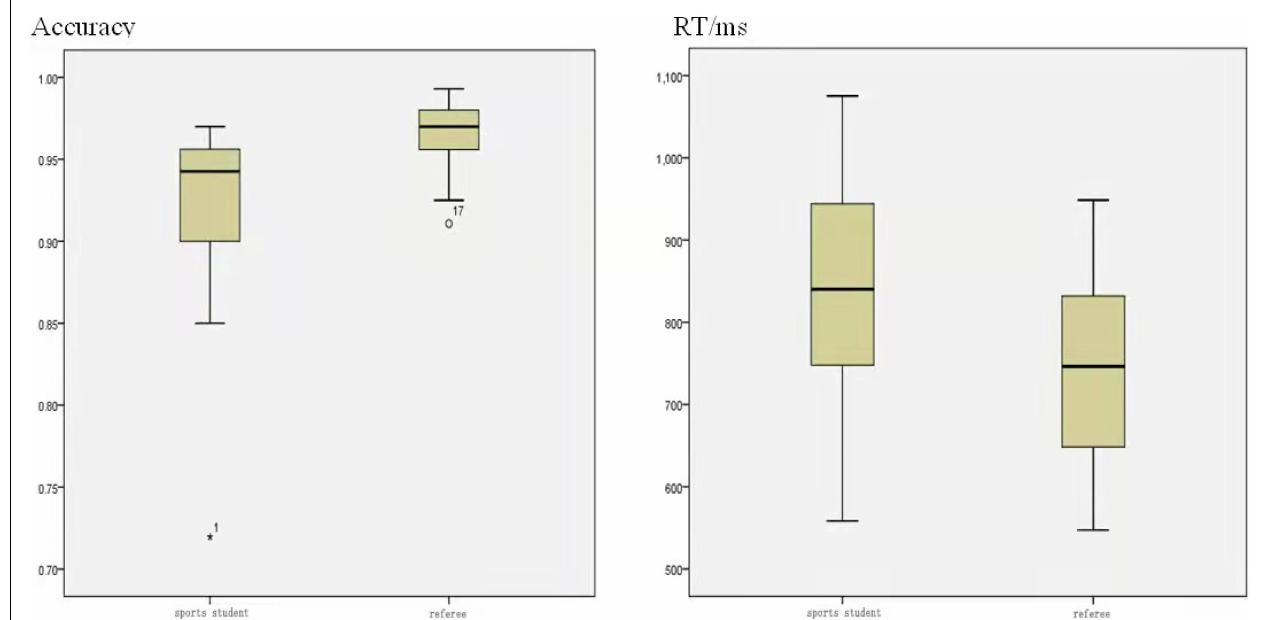
FIGURE 3 | Box plot of the mean distribution of accuracy and response time between